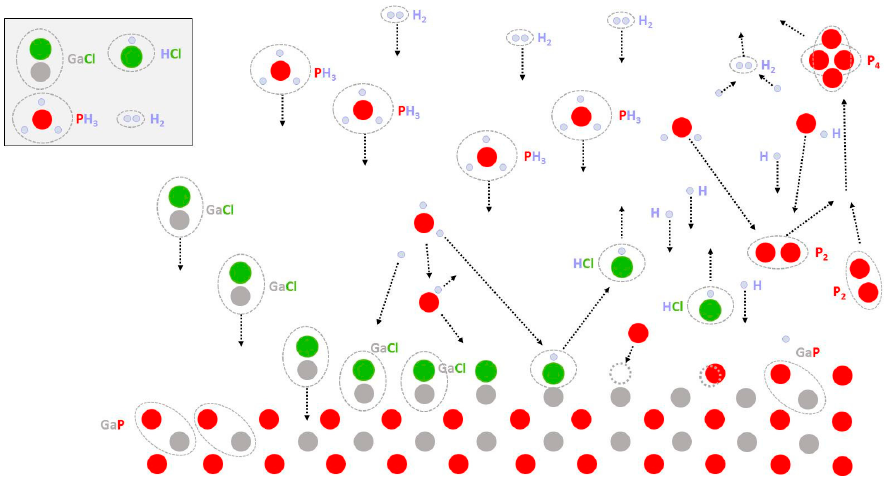
Figure 18. Illustration of the most probable growth chemistry of GaP growing by HVPE in a low-pressure horizontal quartz reactor.